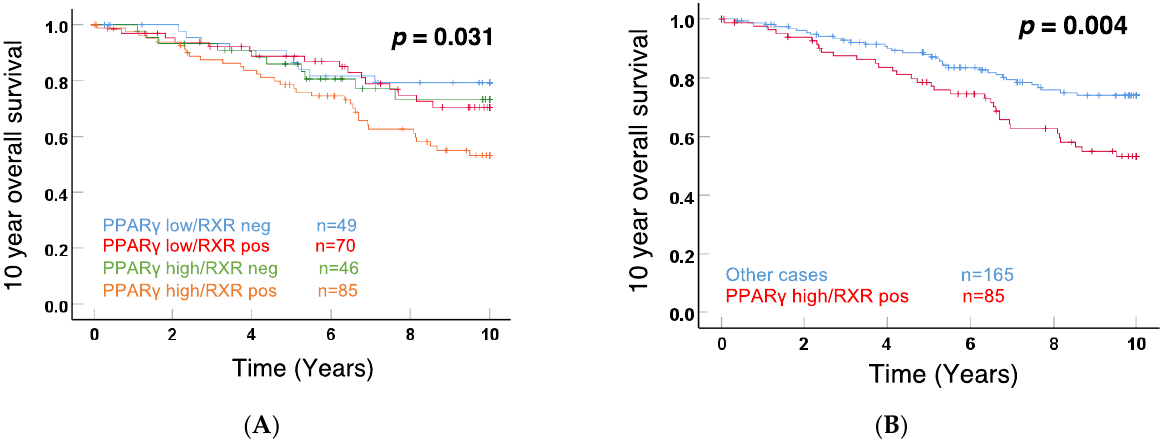
Figure 2. The ten- year OS rates for the 250 breast cancer cases with combined RXRα/PPARγ Figure 2. The ten-year OS rates for the 250 breast cancer cases with combined RXR α /PPAR γ expression divided into 4 subgroups ( A ) and summarized RXRα positive/PPARγ high expression expression divided into 4 subgroups ( A ) and summarized RXR α positive/PPAR γ high expression compared to all other cases ( B ) with indication of the respective p -value. compared to all other cases ( B ) with indication of the respective p